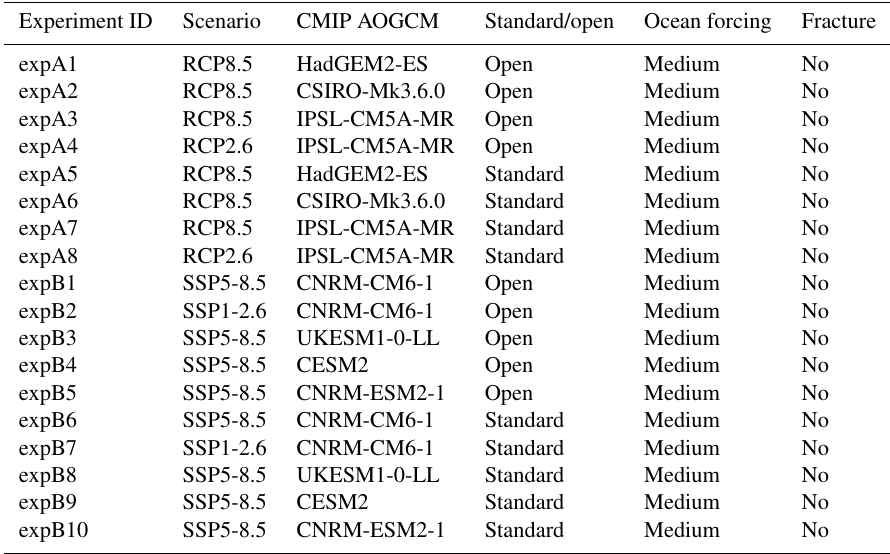
Table A1. Description of ISMIP6 Antarctica Tier 2